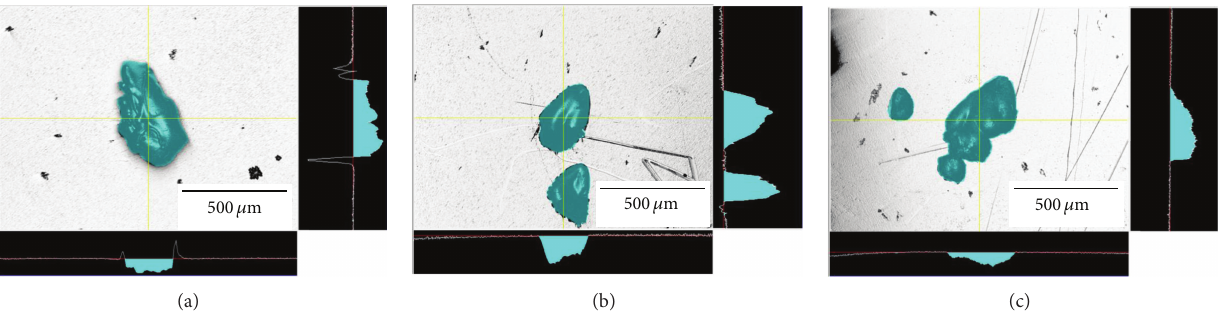
Figure 12: Laser microscope showing pitting corrosion of (a) as-ECAPed, (b) annealed at 573 K, (c) 773